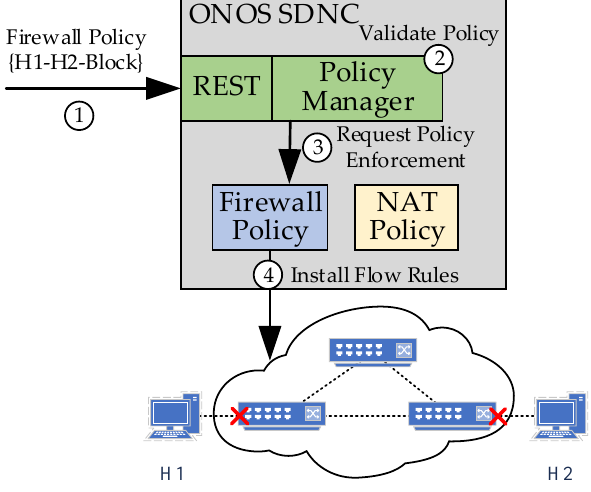
Figure 12. Operation of the Network Policy Framework.